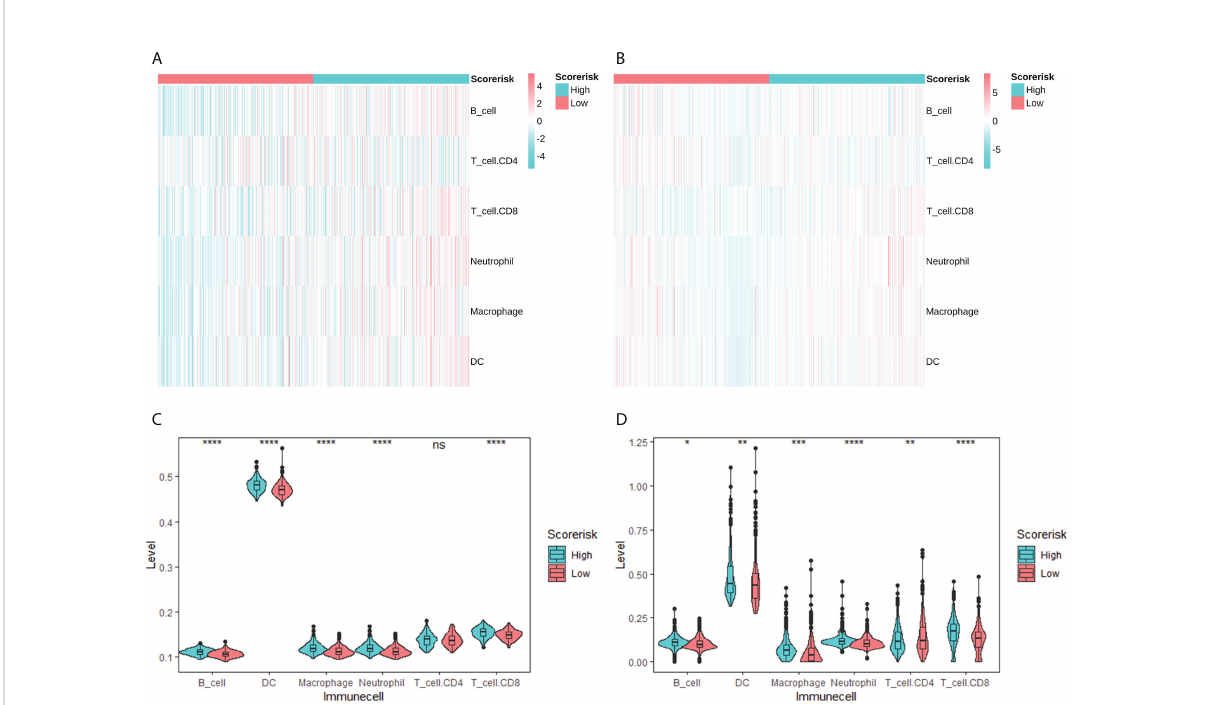
FIGURE 6 Correlation between CARS and tumor-in fi ltrating immune cells calculated by TIMER. Heatmap of tumor-in fi ltrating immune cells among low- and high-risk groups in TCGA (A) and CGGA (B) cohorts. Difference analysis of tumor-in fi ltrating immune cells, immune scores, and stromal scores in the TCGA cohort (C) and the CGGA cohort (D) . ns, not signi fi cant; * P < 0.05; ** P < 0.01; *** P < 0.001; **** P < 0.0001.